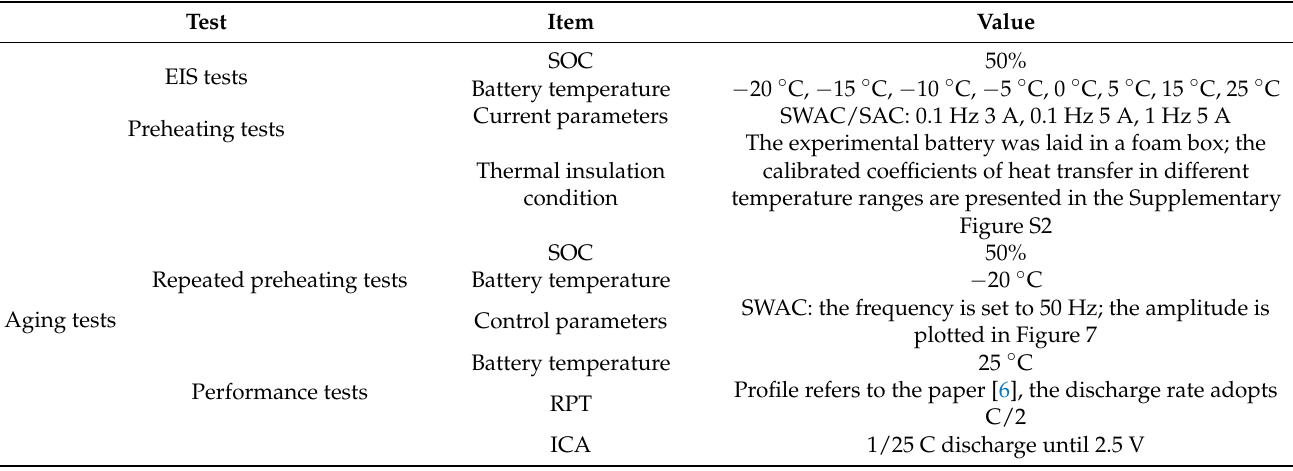
Table 2. The details of the